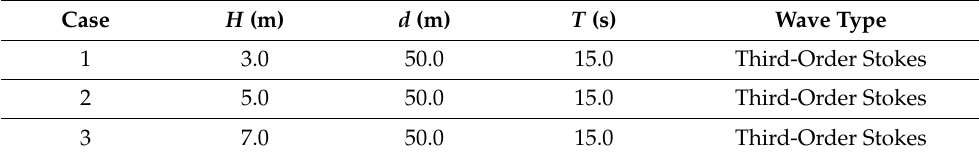
Table 2. Parameters of the ocean waves in hydrodynamics modeling. Case